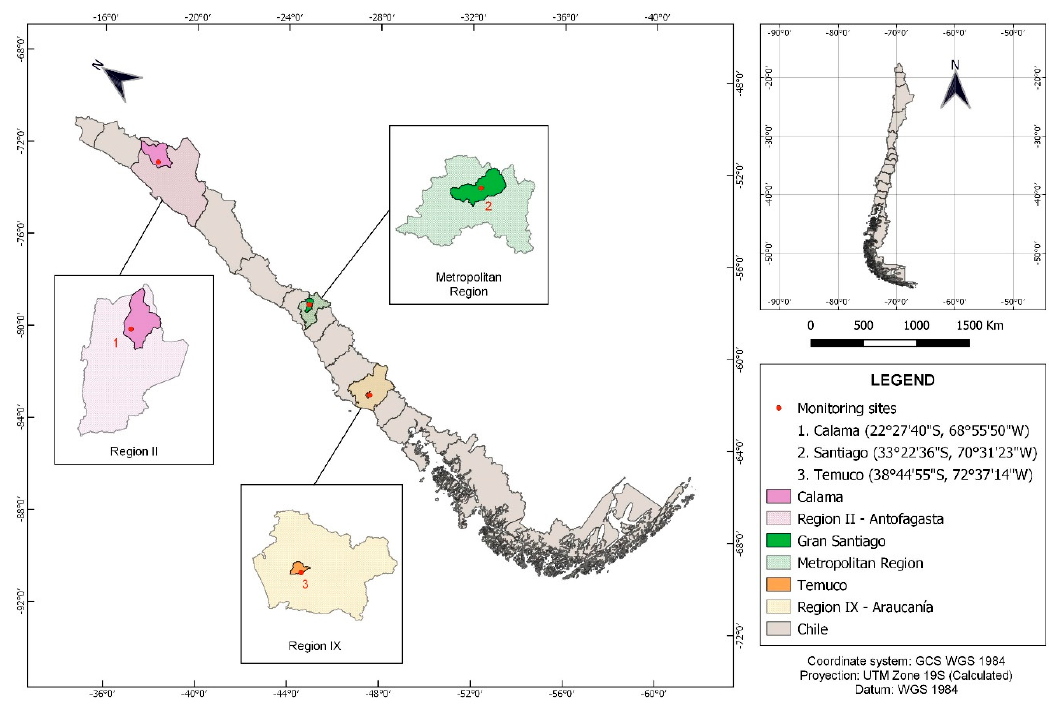
Figure 1. Geographical locations of the three cities analyzed.